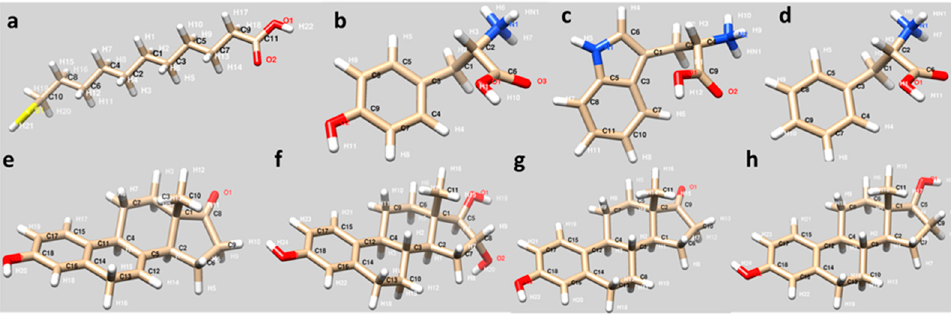
Figure 1. Molecular structures of ( a ) 11-MUA, ( b ) Tyr, ( c ) Trp, ( d ) Phe, ( e ) Equ, ( f ) estriol, ( g ) estrone and ( h ) 17 β -estradiol.